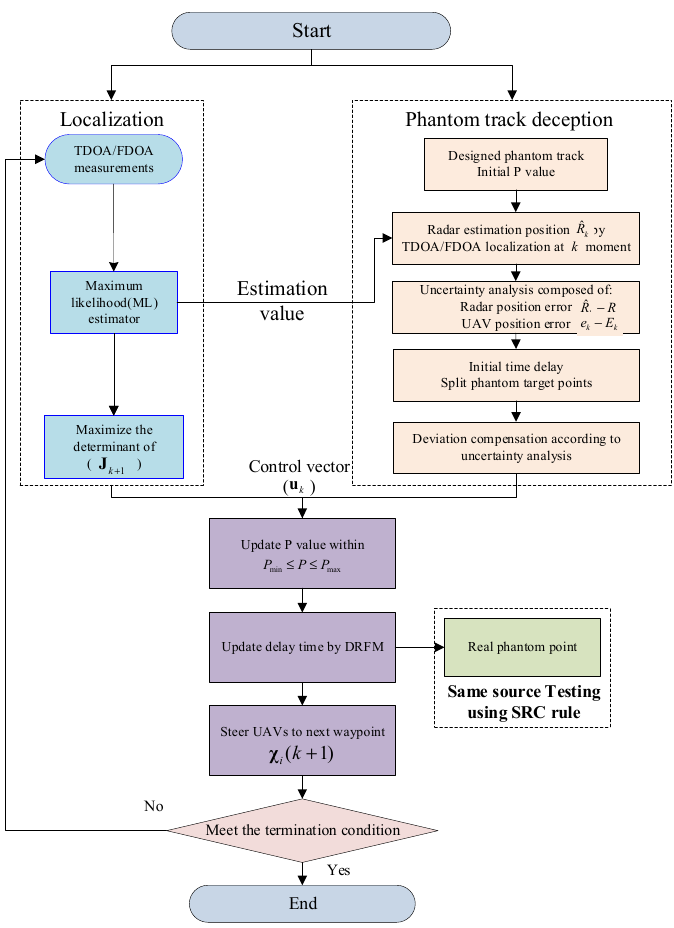
Figure 5. Process of localization and phantom track deception method.